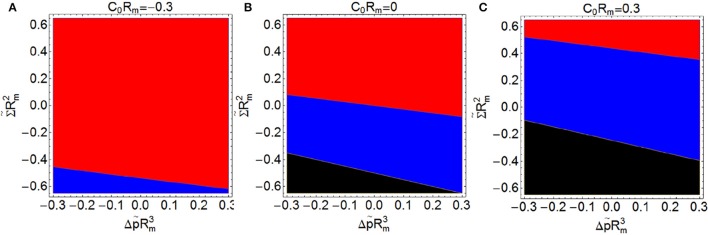
Constriction force Fc compared with the reference constriction force Fc, 0 (defined as the constriction force in the case with C0 = Σ = Δp = 0), both forces are computed at the beginning of constriction (s = 0.2). (
Fc > Fc, 0, 
Fc < Fc, 0, 
Fc imaginary: impossible constriction). Constriction force is shown as a function of Σ~Rm2 (y-axis) and Δp~Rm3 (x-axis) with C0Rm = −0.3 (A), C0Rm = 0 (B), and C0Rm = 0.3 (C). Regions shaded in blue (red) correspond to conditions giving constriction forces lower (larger) than Fc, 0 and regions shaded in black correspond to conditions under which constriction is impossible (imaginary analytical results and no numerical solution).